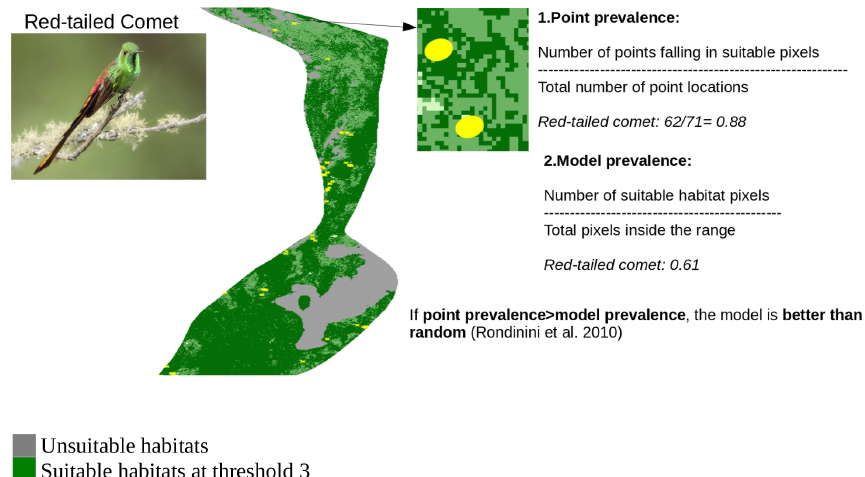
Figure A4. Point validation of the AOH map of the species red-tailed comet using model and point prevalence. The yellow circles represent the buffered point localities of red-tailed comet. Image credit: Andres Vasquez Noboa, Macaulay Library ML 239910751.